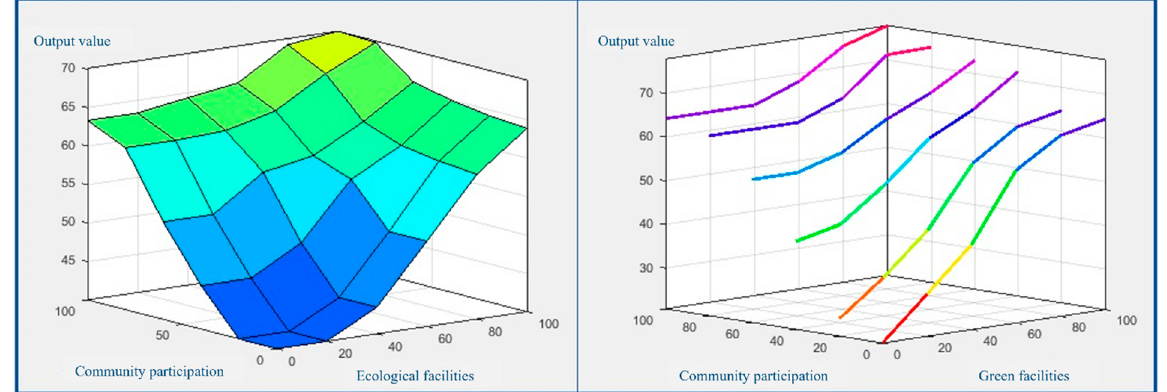
Figure 4. 3D relationship diagram of output values of each dimension.